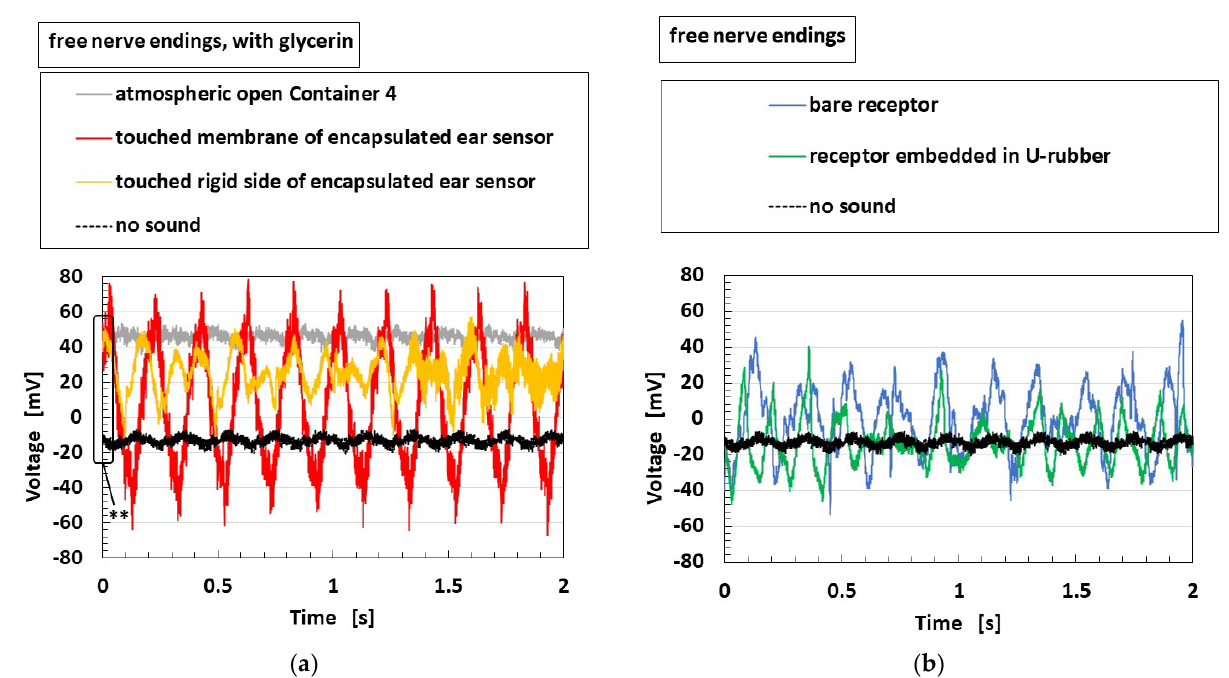
Figure 22. One example of the experimental results of the vibrating auditory sensor on the sound level of a speaker: ( a ) with free nerve endings in glycerin and ( b ) with free nerve